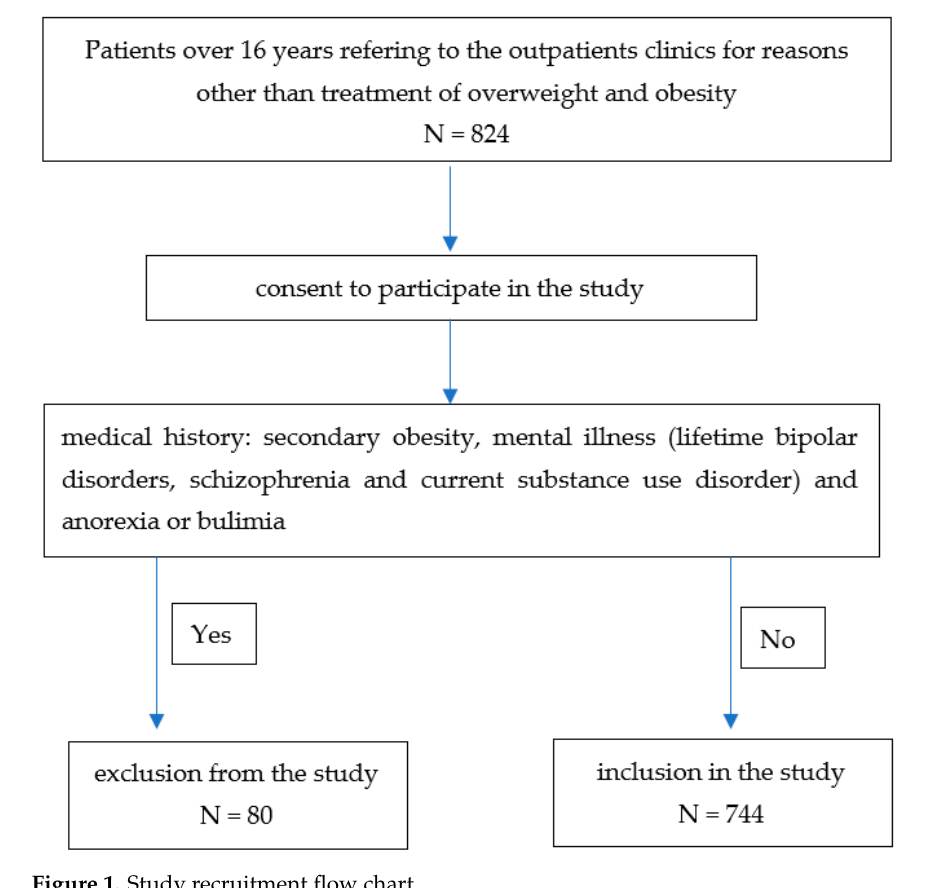
Table 1. Basic characteristics of the study group according to nutritional status. Normal Weight N = 347